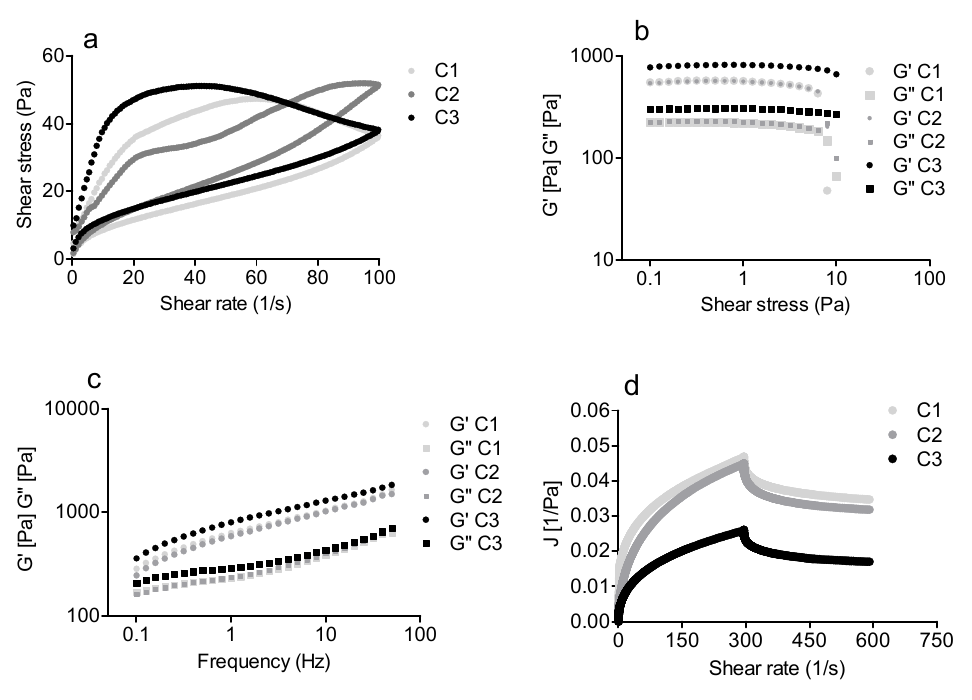
Figure 7. Rheological studies of the creams. ( a ) Flow curves, ( b ) stress sweep, ( c ) frequency sweep and ( d ) creep and recovery. C1 (base cream), C2 (base cream plus FA ) and C3 (base cream plus FAEE